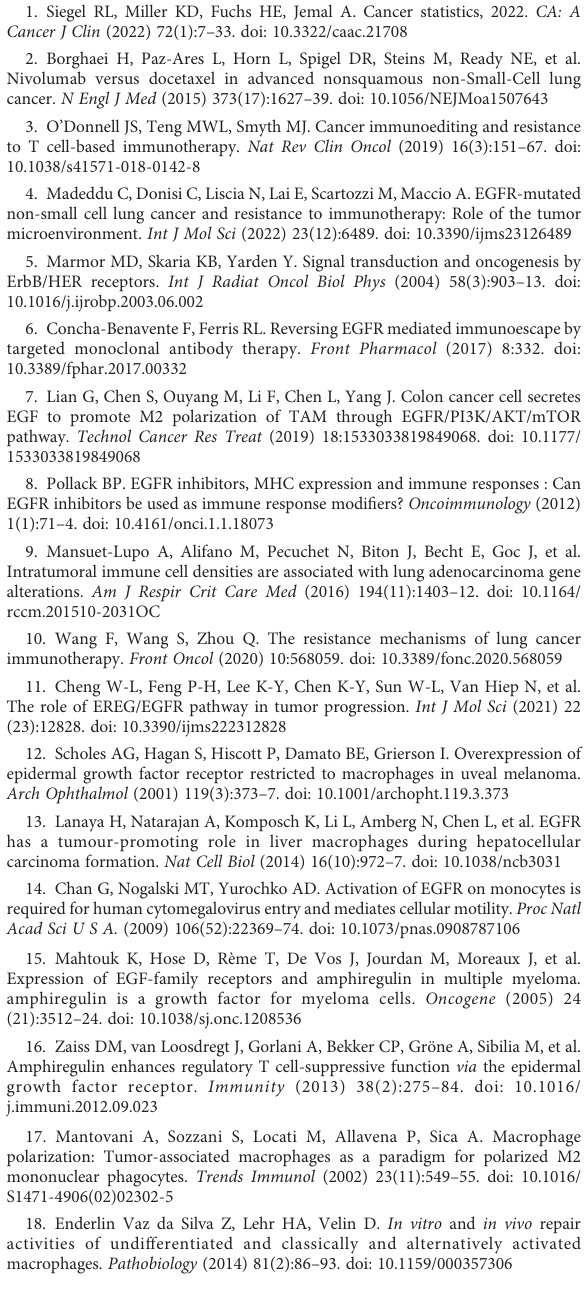
SUPPLEMENTARY FIGURE 2 Kaplan – Meier plot analysis of Progression free survival (PFS) according to the HB-EGF mRNA expression level in patients with LUAD (A) and LUSC (B) using combine 4 GEO datasets including GSE29013, GSE31210, GSE50081 and GSE8894. Wecalculatedp valuesby usingthe log-ranktest.